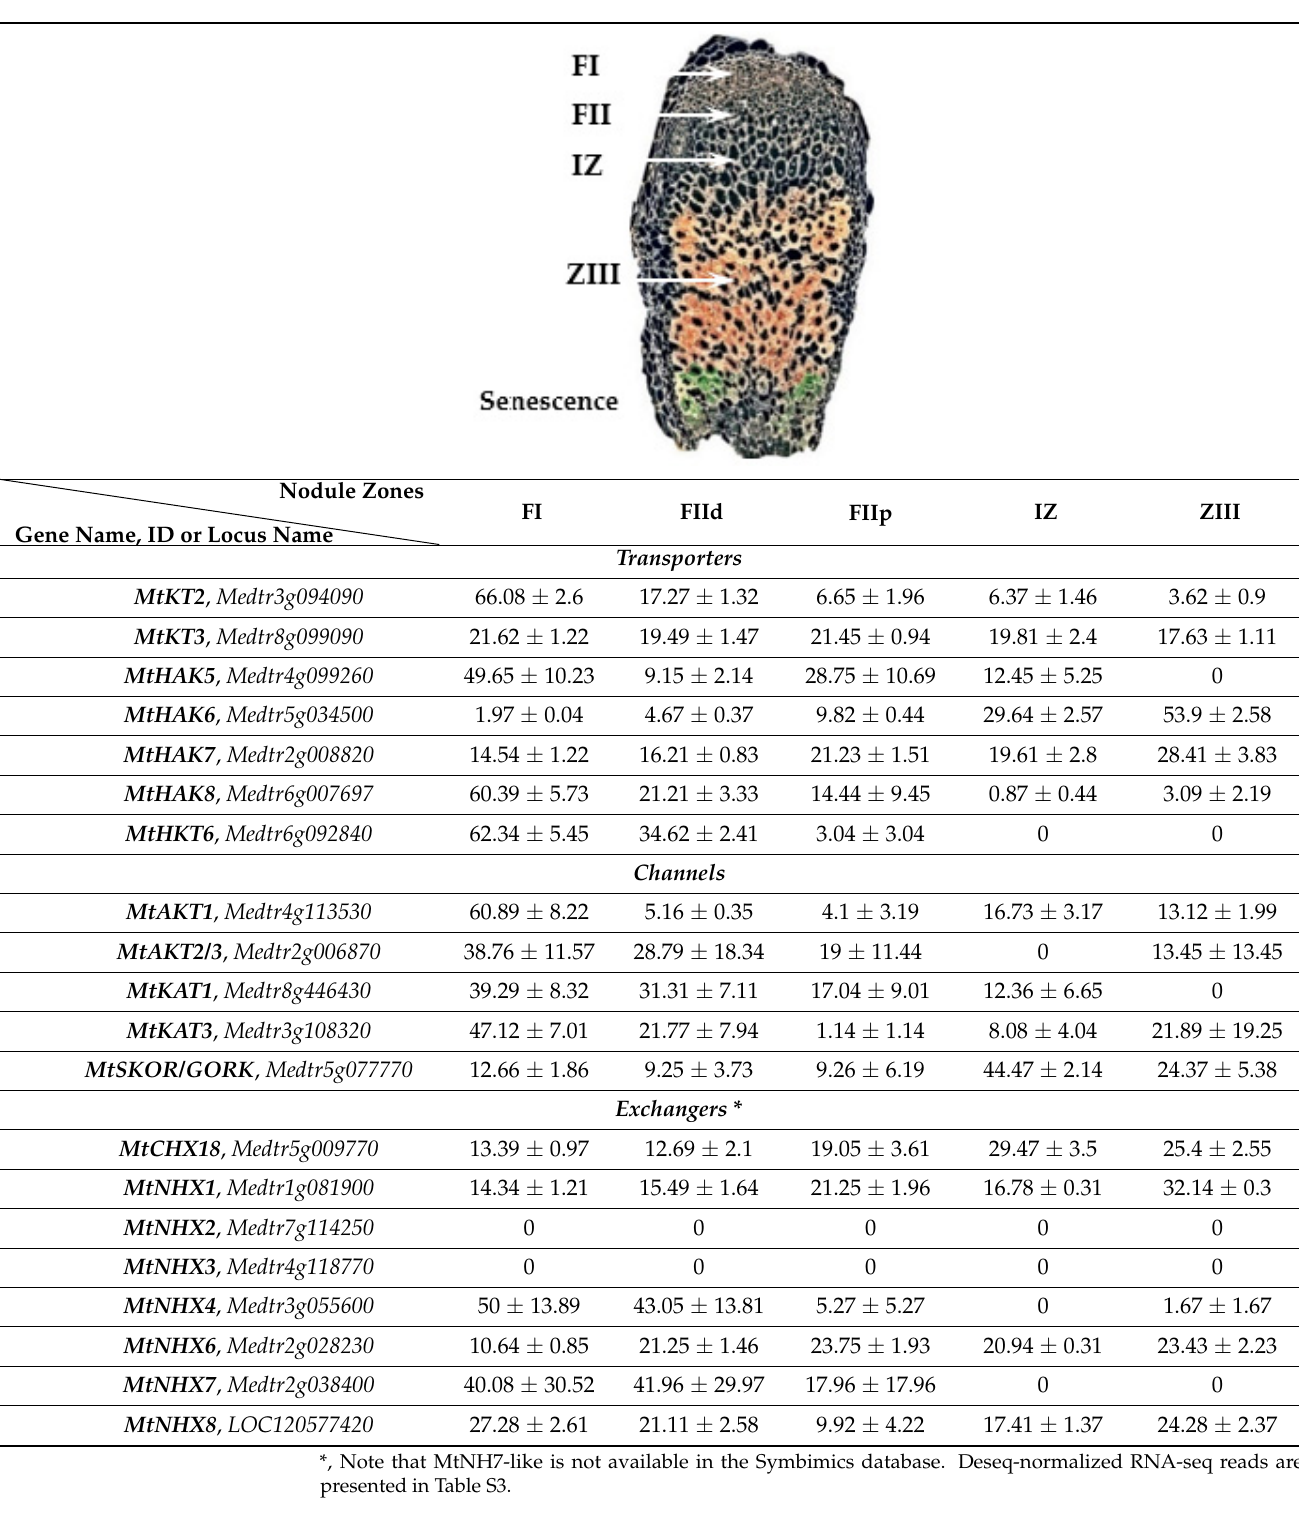
Table 1. Expression of M. truncatula genes, encoding proteins of the inward transport of potassium and cation/sodium exchangers in the nodule developmental zones. Data (relative read distribution among zones (%)) were obtained from the Symbimics database. FI: Meristem; FIId: Distal infection zone; FIIp: Proximal infection zone; IZ: Interzone II–III; ZIII: nitrogen-fixing zone, mature zone.